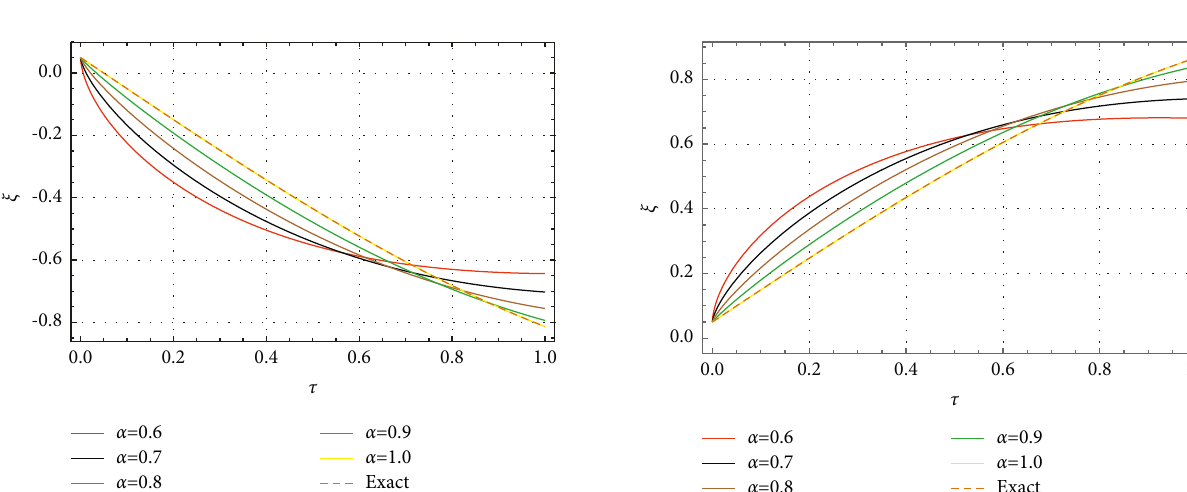
Figure 4: The approximate and exact solutions to the imaginary part of Example